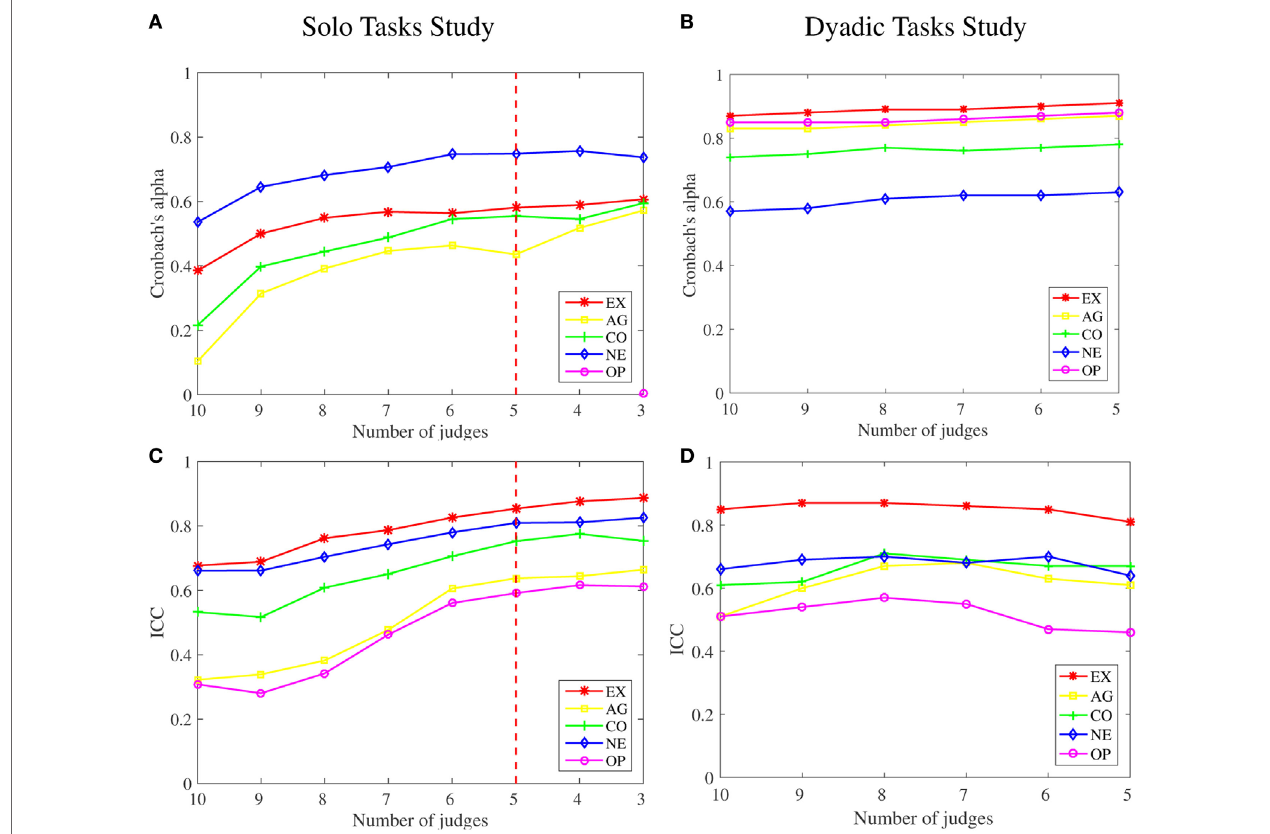
FigUre 3 | changes in cronbach’s α values (a,B) and icc values (c,D) as a function of number selected judges (k) for different traits in the aV communication condition for solo Tasks study (a–c) and Dyadic Tasks study (B–D)